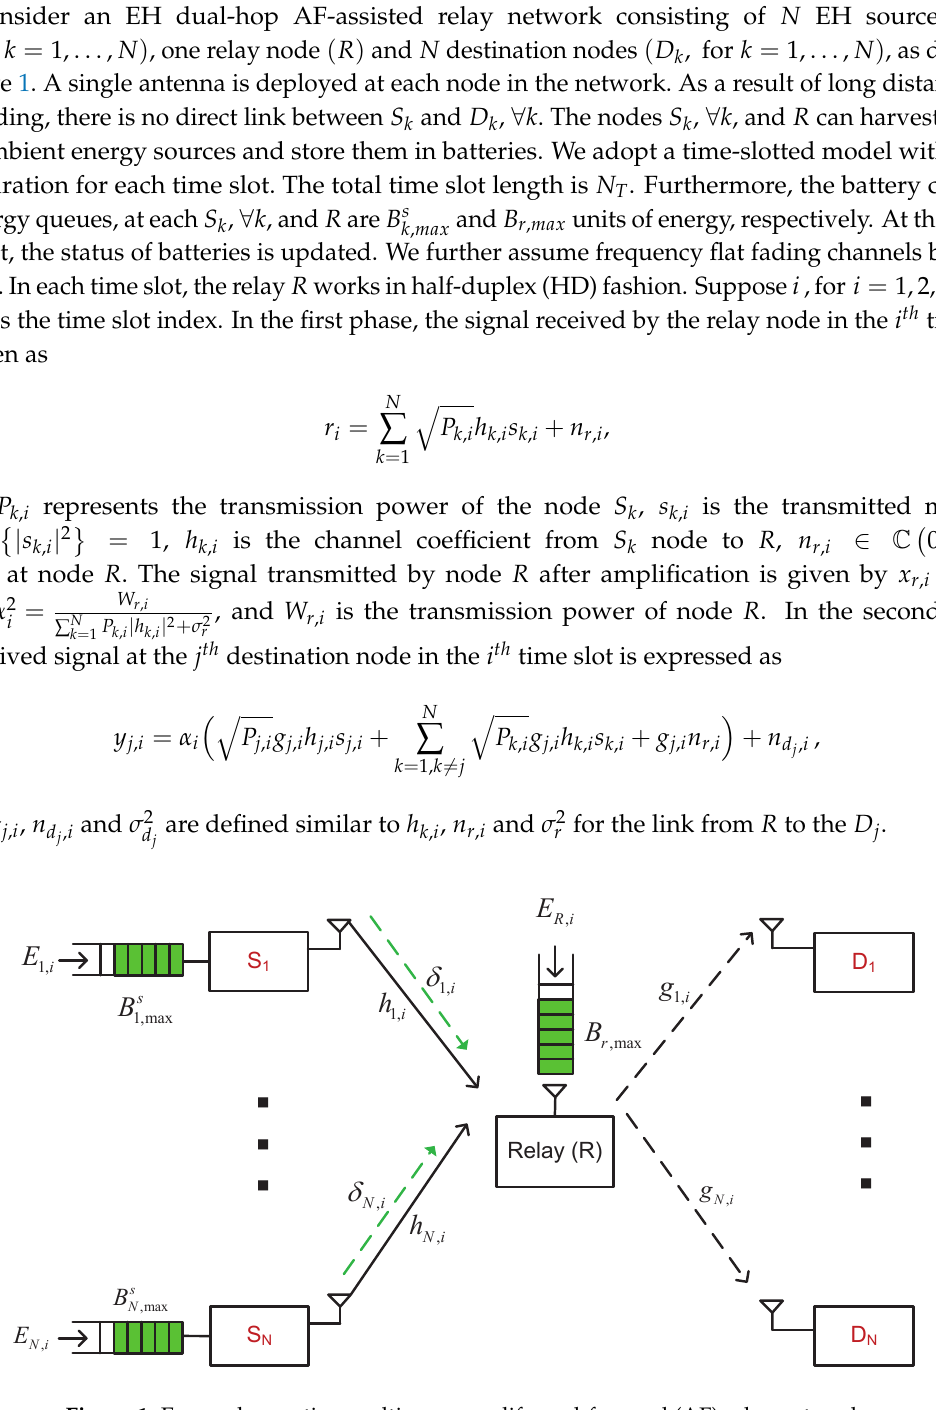
Figure 1. Energy harvesting multi-user amplify-and-forward (AF) relay